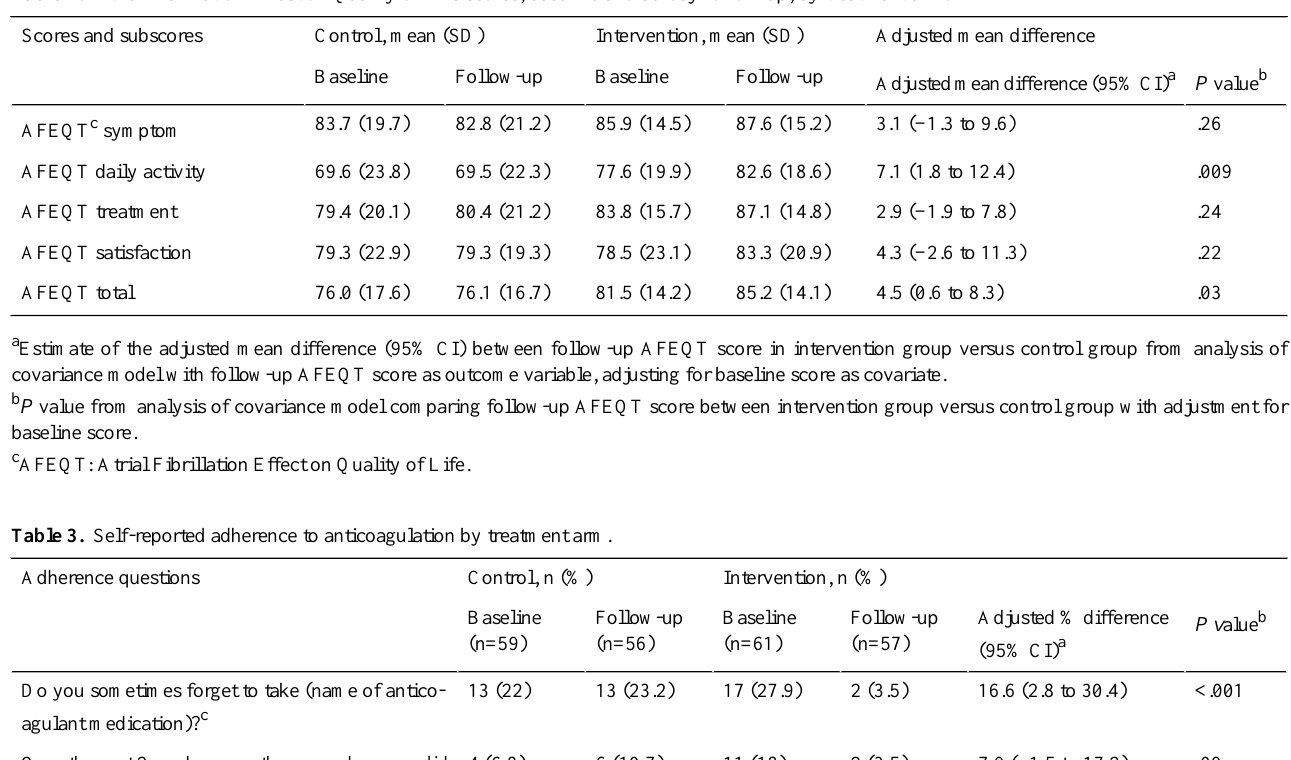
Table 2. Atrial Fibrillation Effect on Quality of Life scores, baseline and 30-day follow-up, by treatment arm.